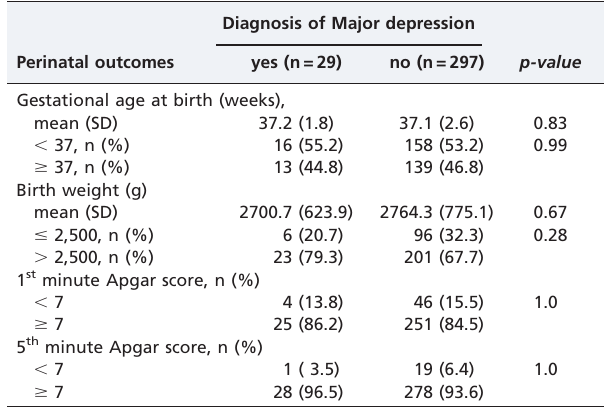
Table 4 - Association of perinatal outcomes with a PRIME- MD diagnosis of major depression during pregnancy in women with medical